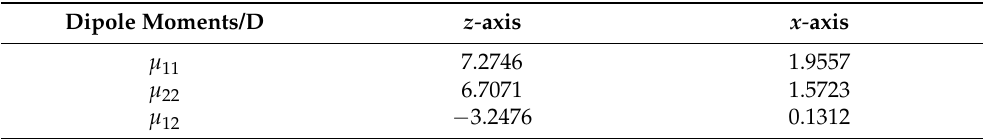
Table 1. Ab initio obtained values of dipole moments (in Debye) of the ground and first singlet excited electronic state of the molecular complex shown in Figure 3.